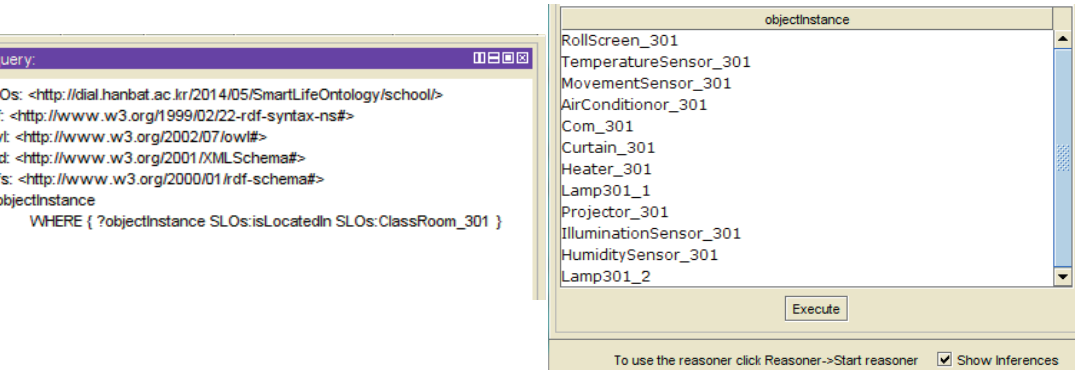
Figure 18. Example of object query result.